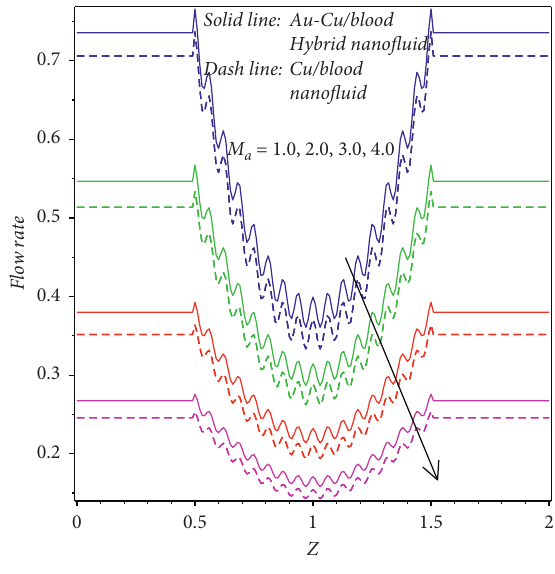
Figure 24: Behaviour of M